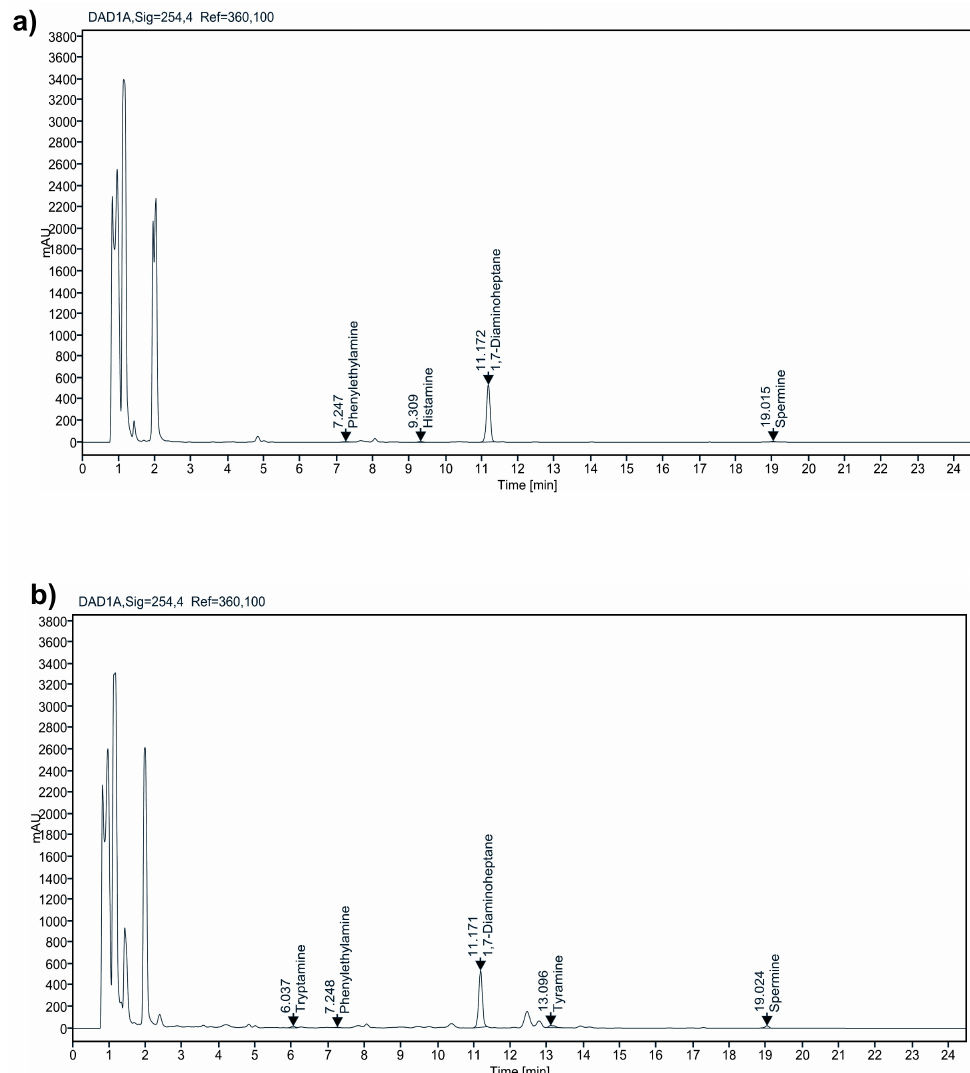
Figure 2. Representative chromatographic separation of biogenic amines in the fresh ( a -string) and ripened ( b -cheddar) cheeses from the farmsteads in the Republic of